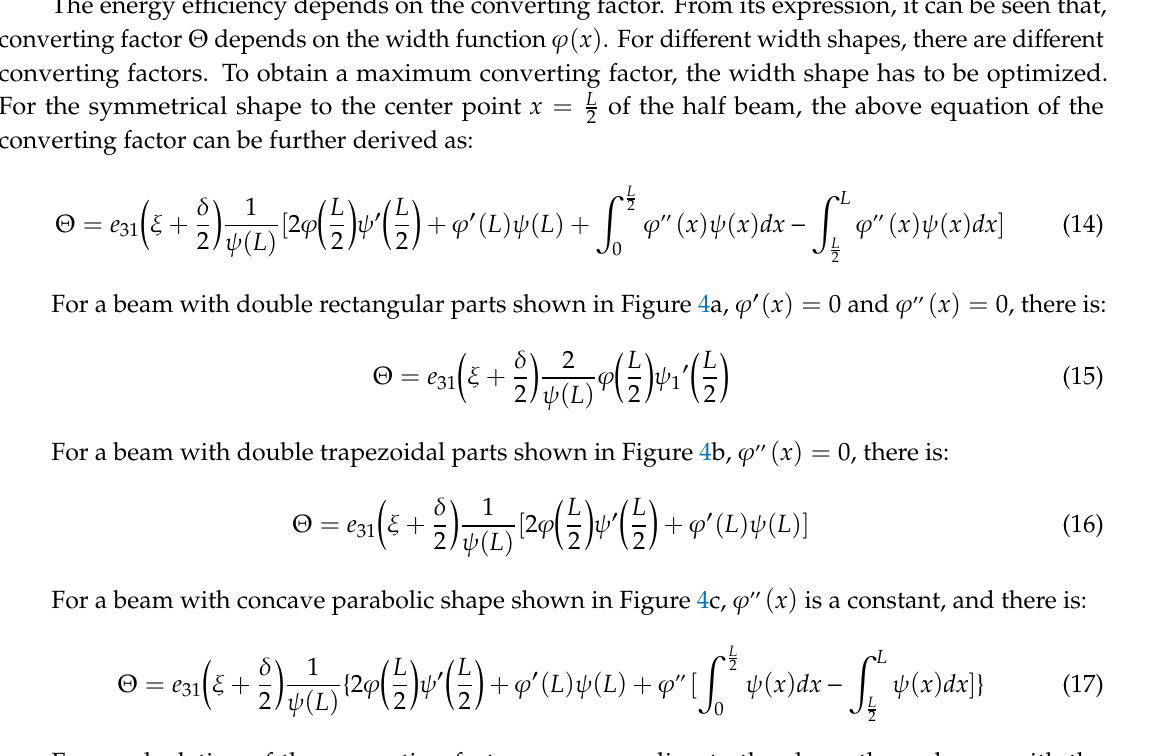
The energy efficiency depends on the converting factor. From its expression, it can be seen that, converting factor 𝛩 depends on the width function 𝜑(𝑥) . For different width shapes, there are different converting factors. To obtain a maximum converting factor, the width shape has to be optimized. For the symmetrical shape to the center point 𝑥 = 𝐿 of the half beam, the above equation 2